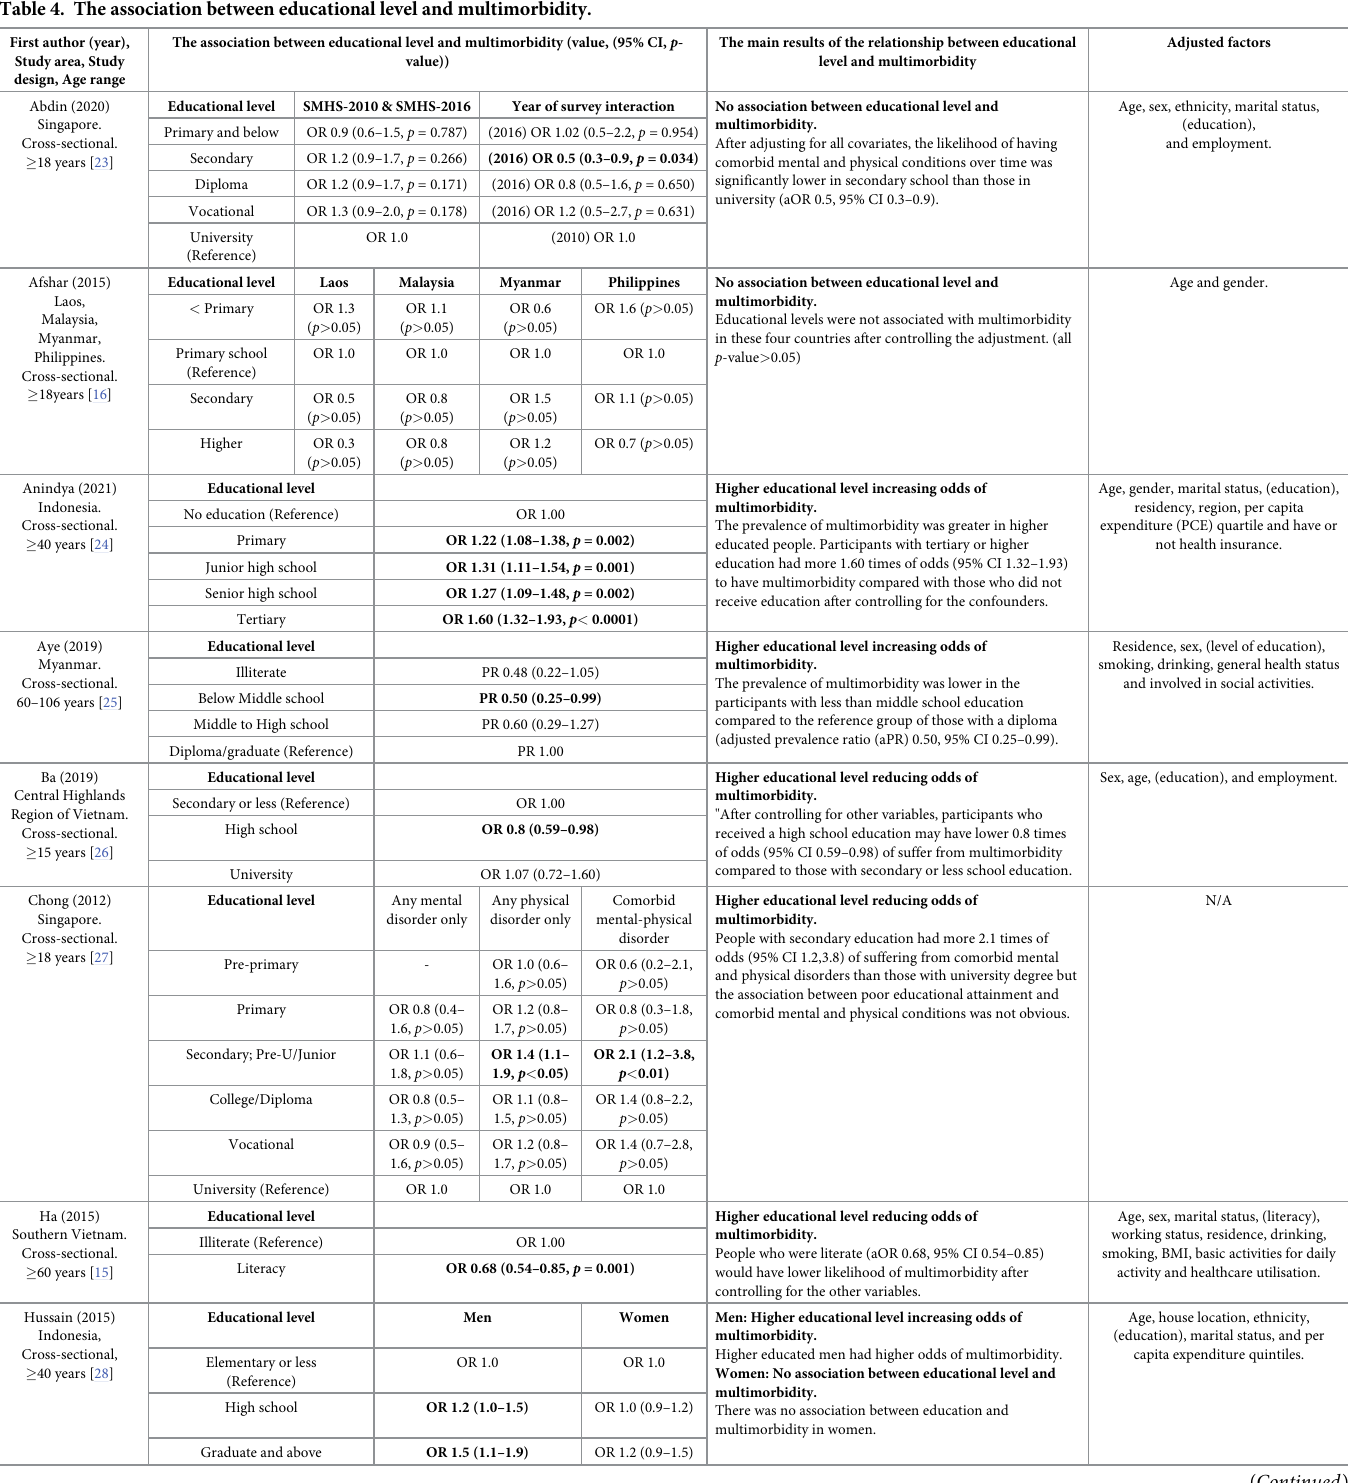
Table 4. The association between educational level and multimorbidity. Firstauthor(year),